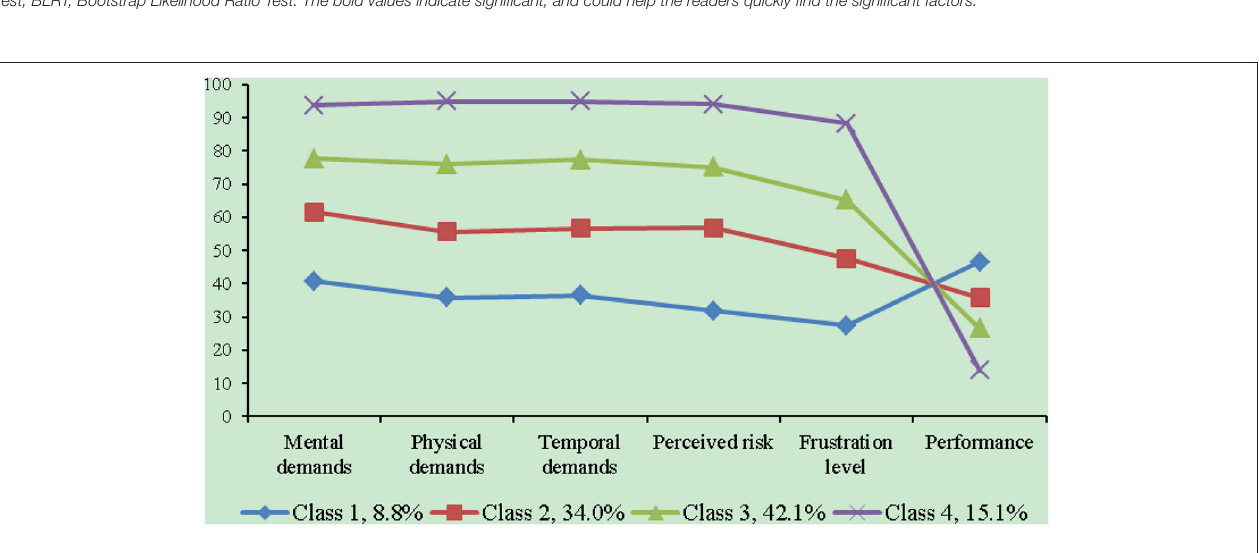
FIGURE 1 | Physician workload scores in different latent